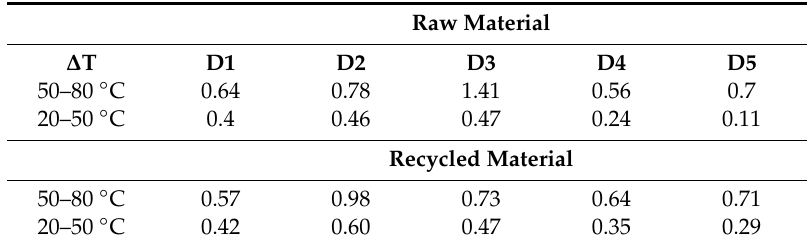
Table 3. Dimensions di ff erences (mm) for ∆ T = 20–50 ◦ C and ∆ T = 50–80 ◦ C.